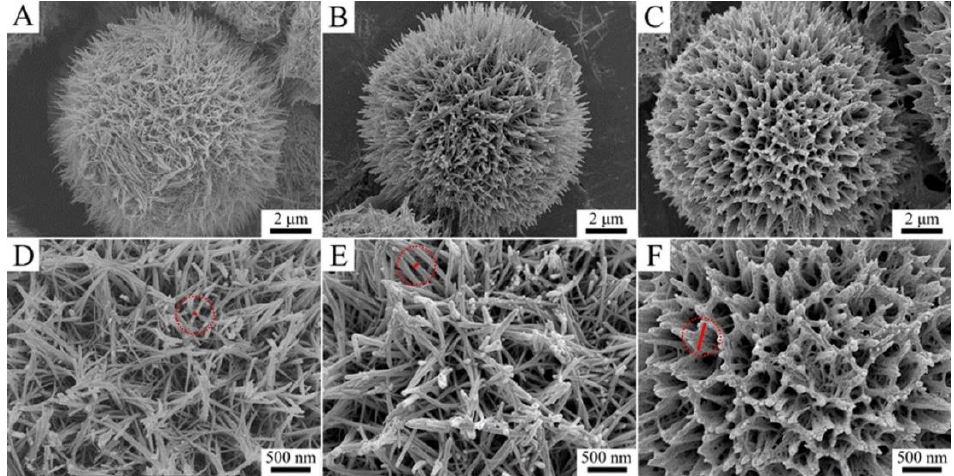
Figure 2. SEM images of MnO 2 ( A , D ), MnO 2 @PSS/PDDA/PSS ( B , E ) and MnO 2 @(PSS/PDDA) 3 /PSS ( C , F ).